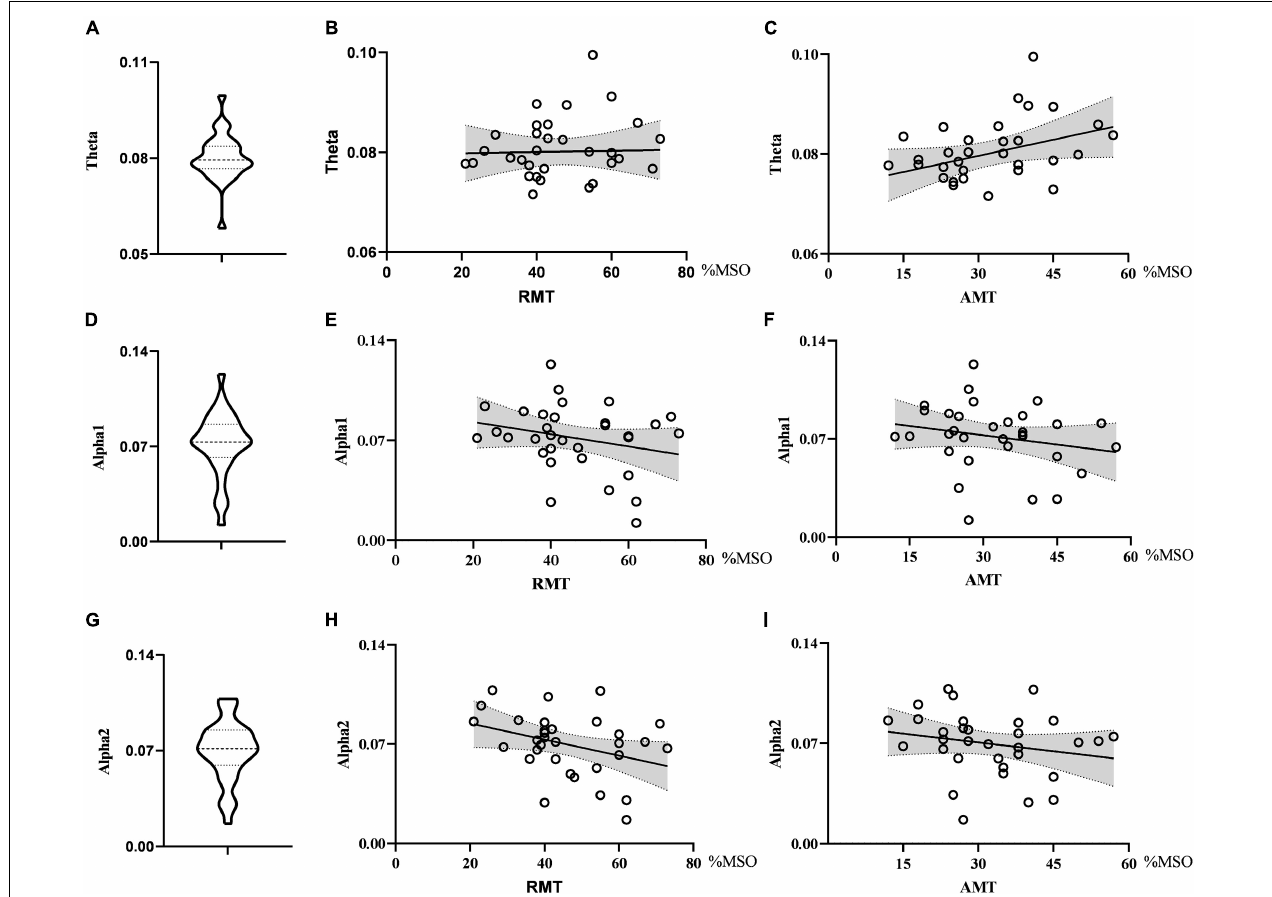
FIGURE 3 | Violin diagrams and scatter diagrams. Violin diagrams showed the distribution of nodal efficiency in theta, alpha1, and alpha2 band (A,D,G) . Scatter diagrams showed the correlation between nodal efficiency and motor threshold (B,C,E,F,H,I)